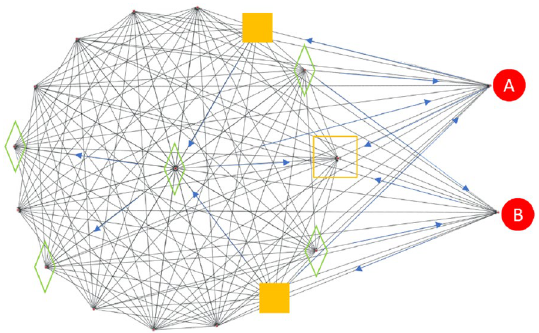
Figure 4. One CLIIP result of the small cluster within 1 day of IDG as an example. The forward tracking is based on the connection of people, and each edge is directed toward other nodes. We highlight the important arrows to explain this tracking method. The bigger squares depict a higher probability of getting infected, like the one in the middle of the